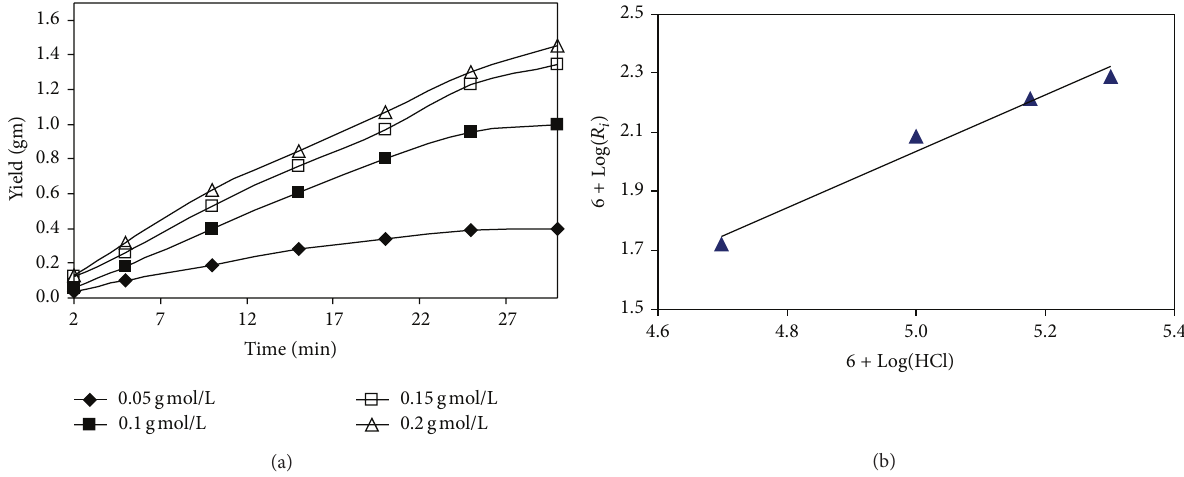
Figure 5: (a) Yield-time curve for the effect of HCl concentration on the aqueous oxidative polymerization of (POPDA) at different time intervals. (b) Double logarithmic plot of the initial rate and HCl concentration of